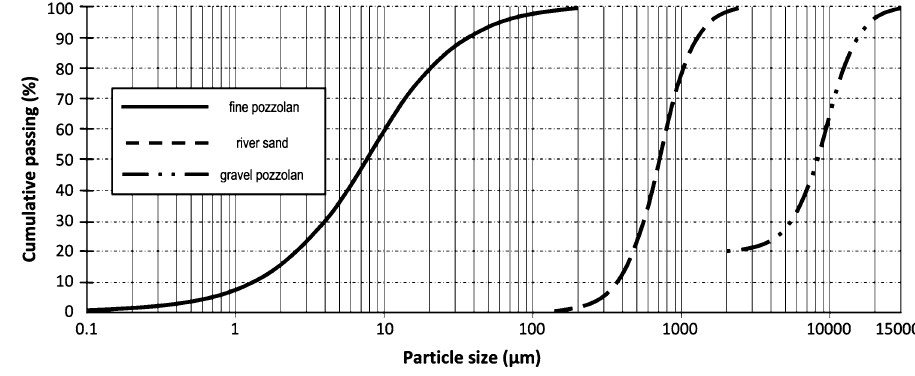
Fig. 2 Particle size distribution of aggregates.